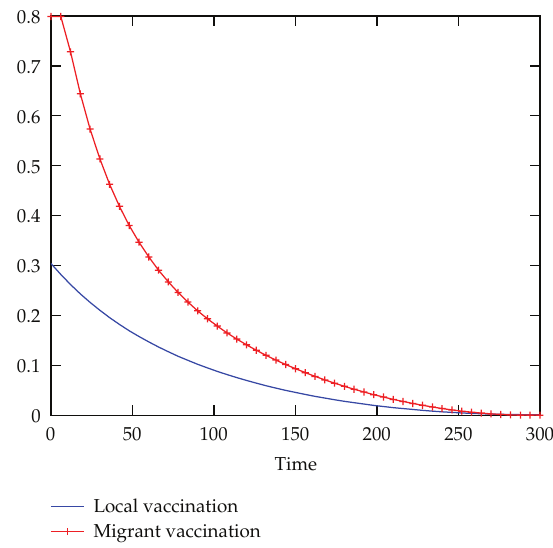
Figure 5: The vaccination strategies for the two groups, Example